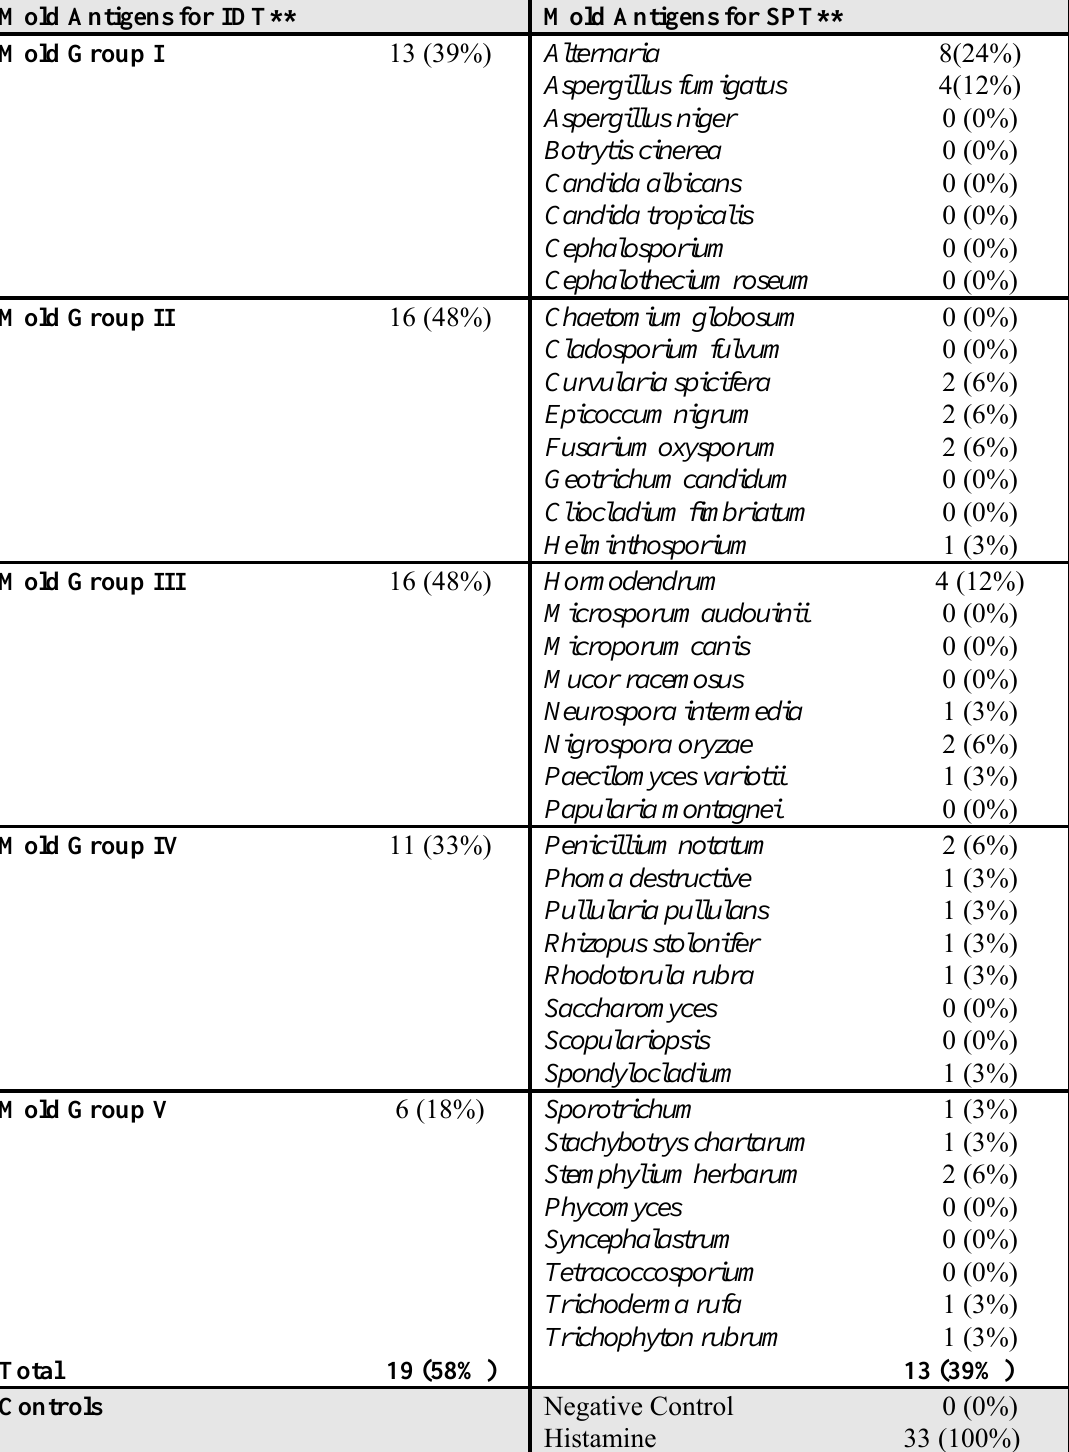
Table 3. Mold Panel for Skin Prick Test (SPT) and Intradermal Testing (ITD)*. Mold Antigens for